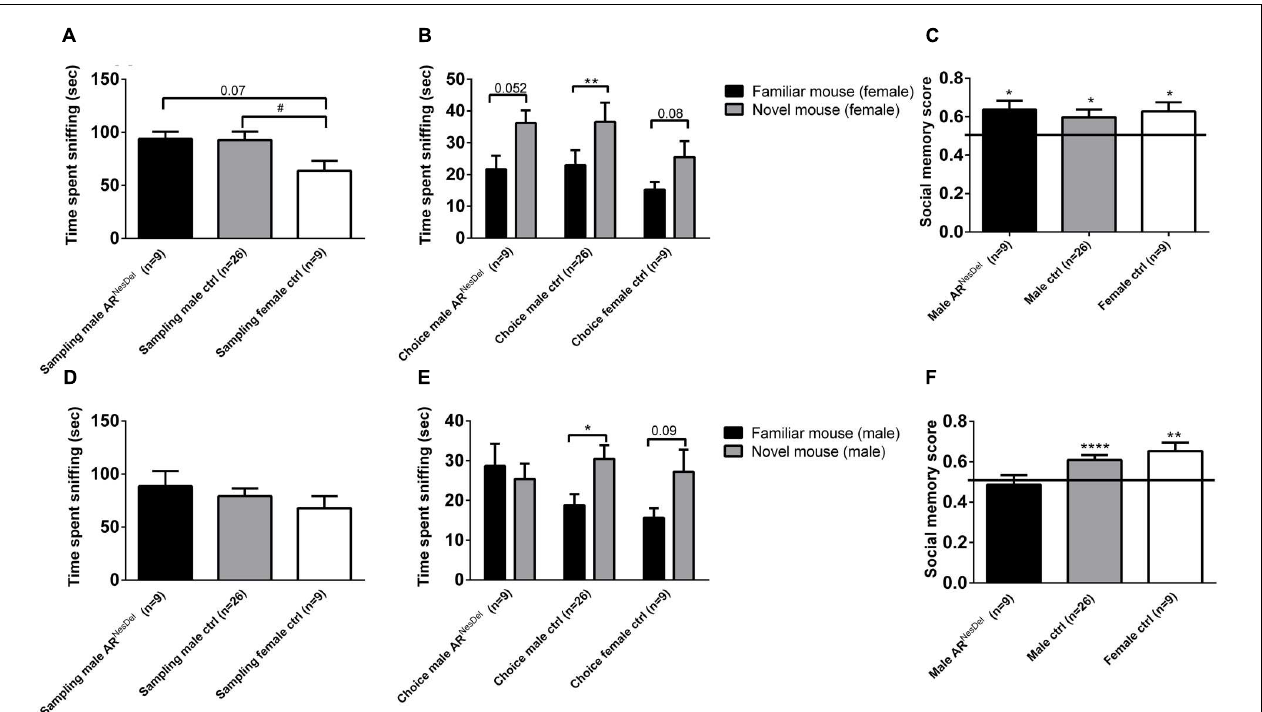
FIGURE 2 | Social investigation and social recognition measured in the social discrimination paradigm in AR NesDel males, male controls (wildtype, AR flox , NesCre + / − ), and female controls (ARflox + / − ). (A) Amount of time spent sniffing female stimulus animals in the sampling phase. (B) Social recognition of female stimulus animals. (C) Social memory score when presented to female stimulus animals. (D) Amount of time spent sniffing male stimulus animals in the sampling phase. (E) Social recognition of male stimulus animals. (F) Social memory score when presented to male stimulus animals. Bars represent mean ± SEM, ∗ p < 0.05, ∗∗ p < 0.01, ∗∗∗∗ p < 0.0001 (for within-group comparison) and # p < 0.05 (for between-group